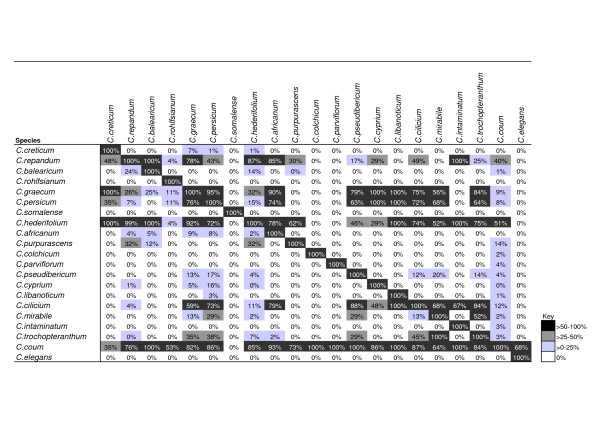
Cross similarity of bioclimatic niche models amongst Cyclamen. Comparison of BIOCLIM models using interpredictivity measure. Heavily shaded cells indicate high agreement. Note the diagonal line indicating 100% self-similarity. Species ordered as phylogeny (fig 7).